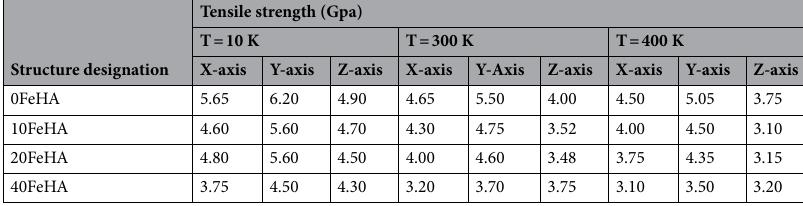
Table 2. Tensile strength of systems at different temperatures and dopant